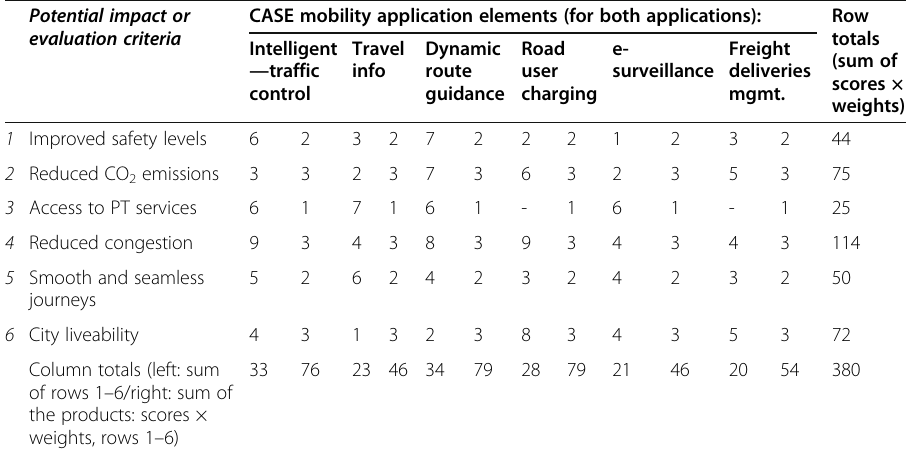
totals (sum of scores ×